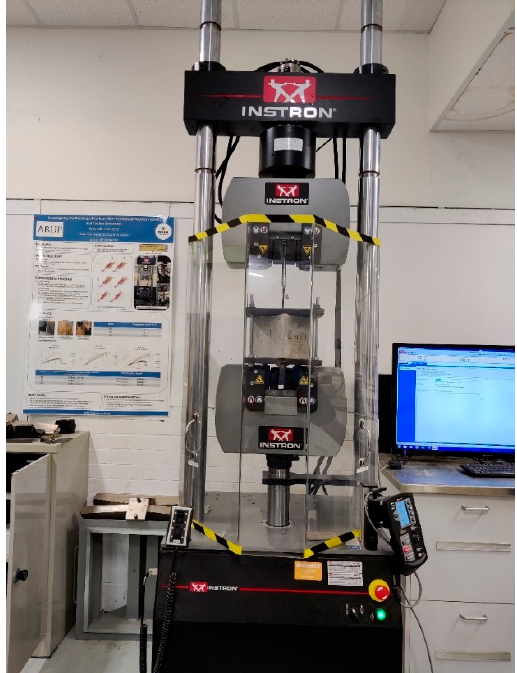
Figure 7 . Universal testing machine with automated data acquisition system for pull-out testing. The steel frame consisted of bottom and top steel plates with holes on all four sides and in the centre, allowing for the FRP bar to pass through. The bottom plate of the steel frame was connected to the jaws of the testing machine, and acted as the reaction end when the pull-out load was resisted by the specimen under testing, as seen in Figure 8.